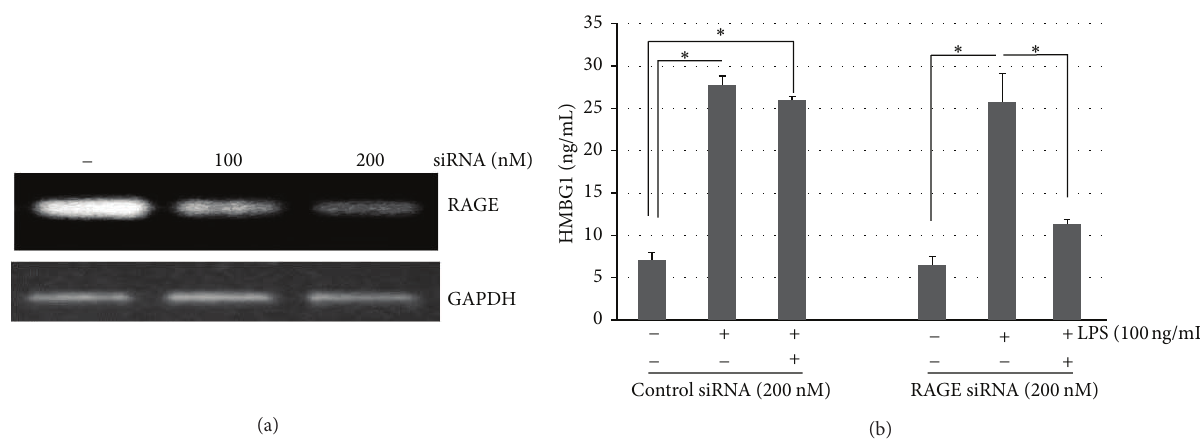
Figure 4: RAGE mediates the effects of LPS-induced HMGB1 release in OLC-1. Cells were transfected with RAGE siRNA suspended in lipofectamine reagent for 48 h. (a) By RT-PCR, RAGE siRNA silences RAGE mRNA expression without affecting house-keeping gene (GAPDH) mRNA expression. A representative experiment is shown, and the RAGE-specific RNA bands are indicated. (b) Cells were transfected with either RAGE siRNA or negative control siRNA and stimulated with LPS for 24 h, and the HMGB1 release in the supernatant was measured by ELISA. Results are expressed as the means ± SD from duplicate experiments. ∗ 𝑃 < 0.05 .